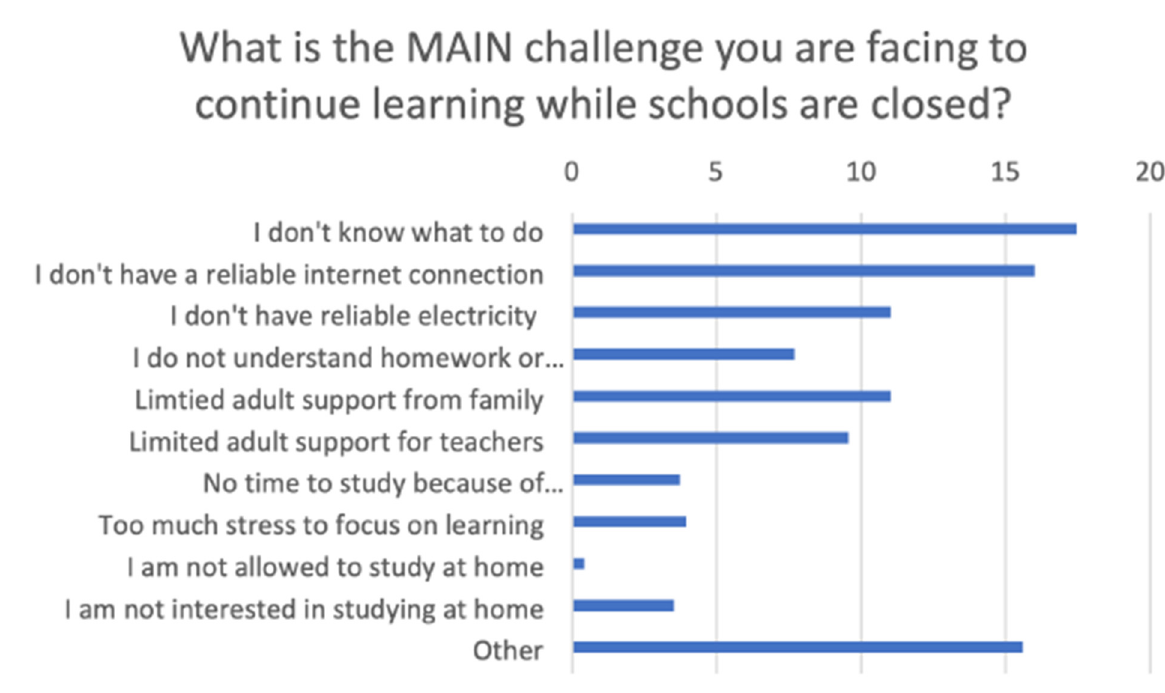
Figure 1. Challenges faced while schools are closed due to the pandemic, overall %.